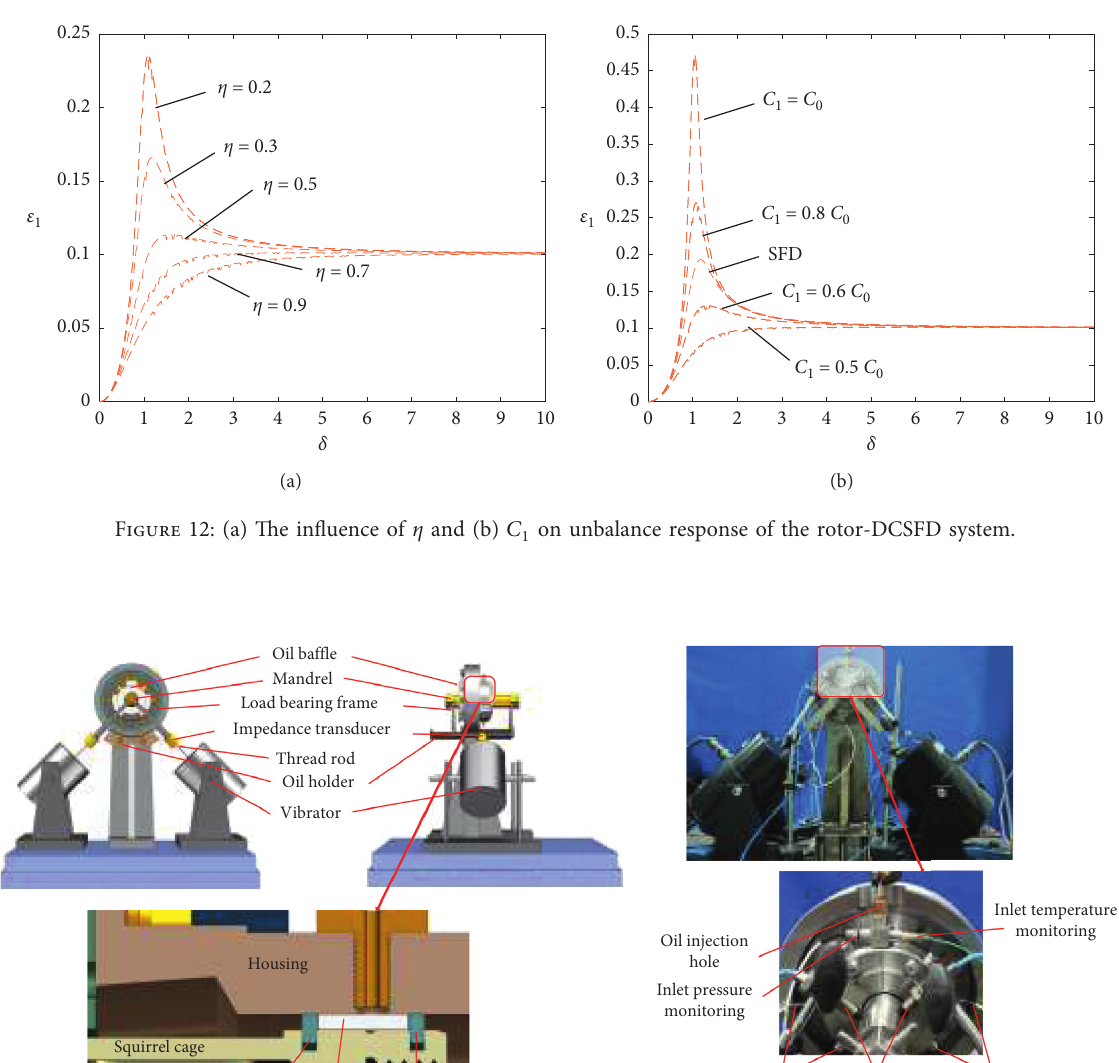
Figure 13: DCSFD bidirectional excitation test